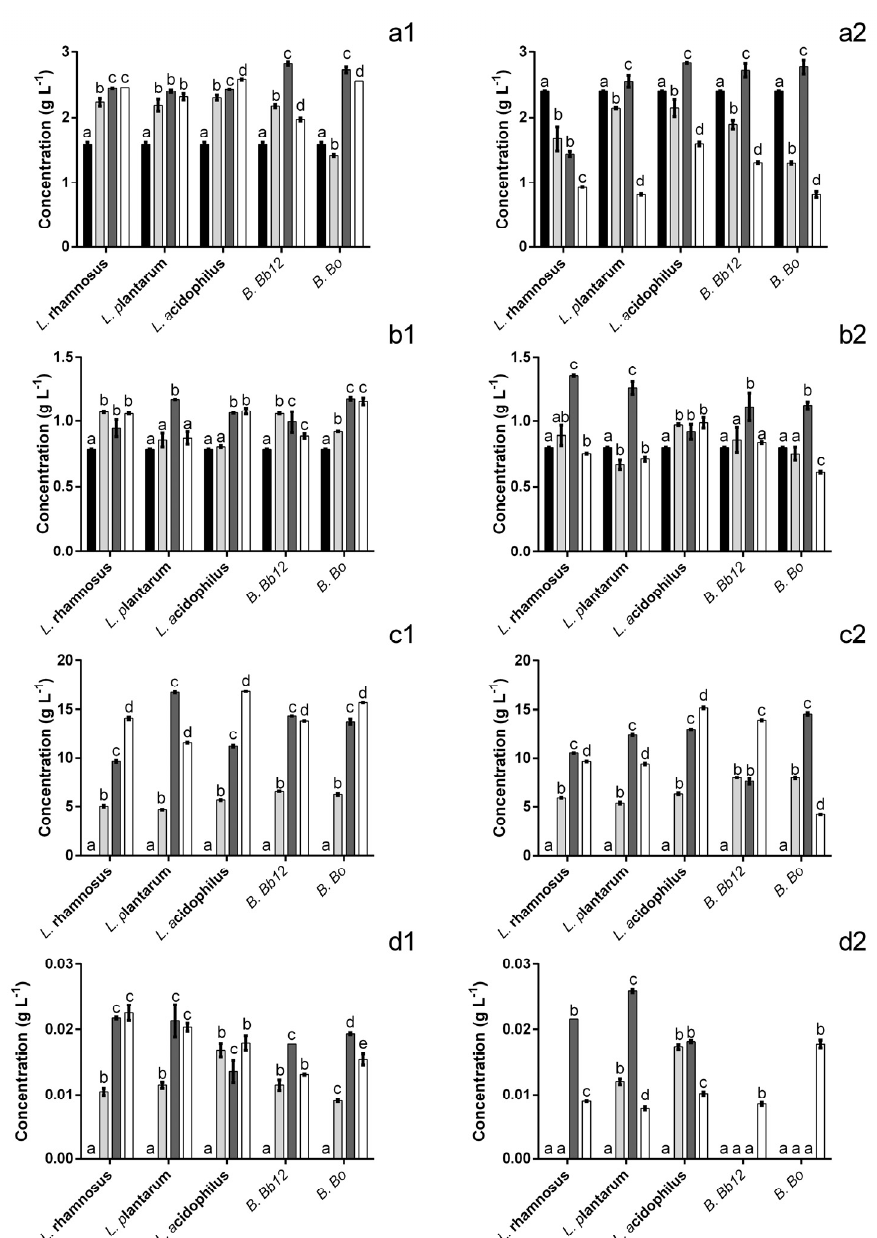
Figure 4. Concentration of acetic ( a ), citric ( b ), lactic ( c ) and propionic ( d ) acids in the presence (1) and absence (2) of extract at 0 ( ■ ), 6 ( ■ ), 12 ( ■ ) and 24 ( ) h. The different letters mark the statistically significant ( p < 0.05) differences between the times for each individual microorganism assayed.